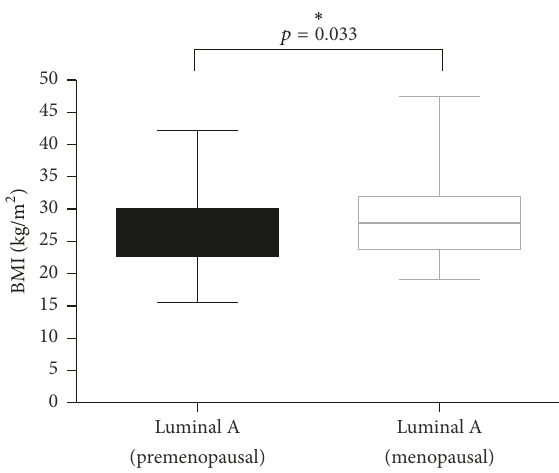
Figure 2: Higher BMI is associated with luminal A tumors in postmenopausal women. ∗ refers to the level of significance.